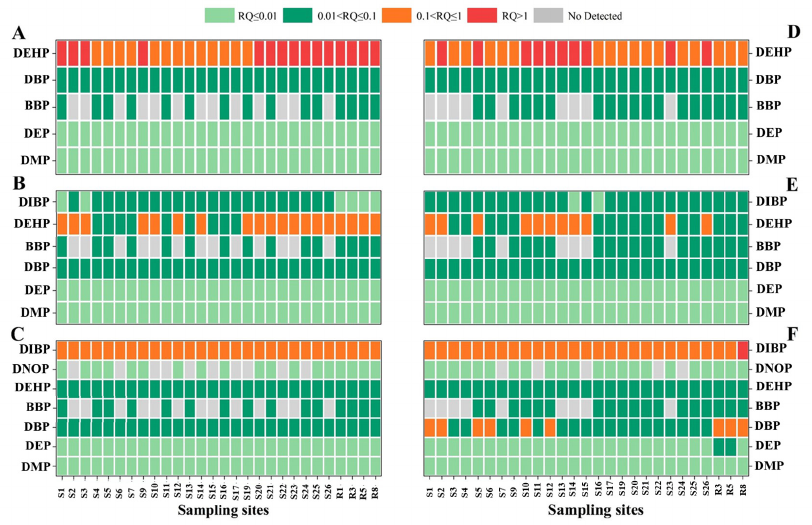
Figure 5. Results of ecological risk assessment of the selected PAE species exposed to the sensitive aquatic organisms: algae ( A ), crustacean ( B ), fish ( C ) in October and algae ( D ), crustacean ( E ), fish ( F ) in May.